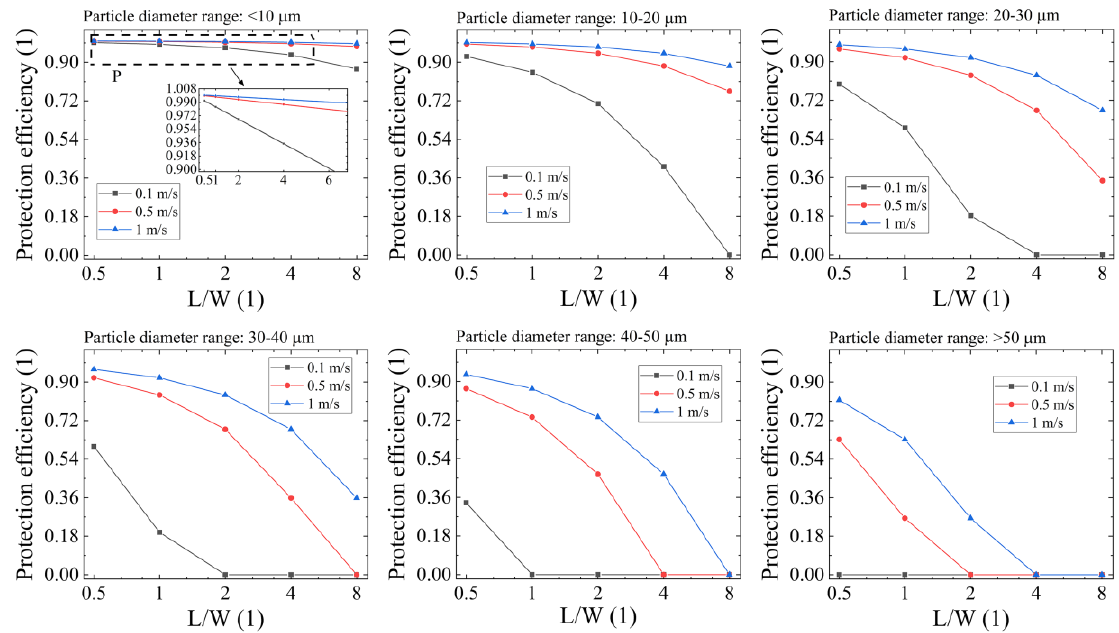
Figure 6. Protection efficiency of laminar flow ( η ) vs. particle height ratio ( L / W ) in preventing particle invasion during free- sinking, where particle diameter ranges from <10 μm to >50 μm.